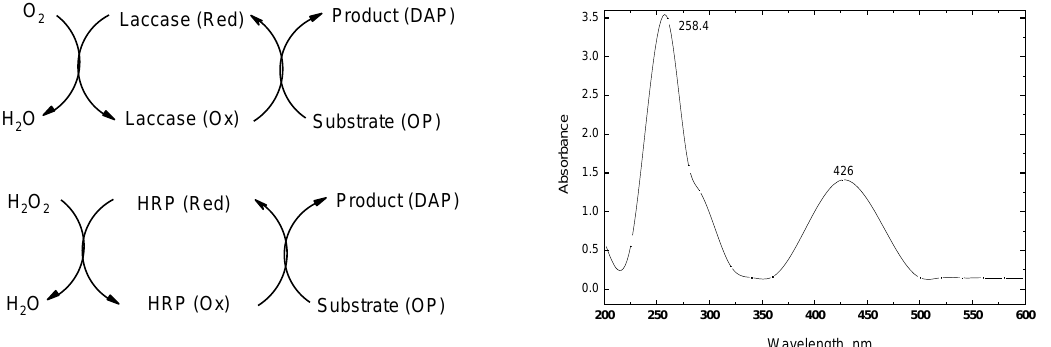
Figure 1. Catalytic mechanism of laccase and HRP Figure 2 UV-VIS spectrum of product in